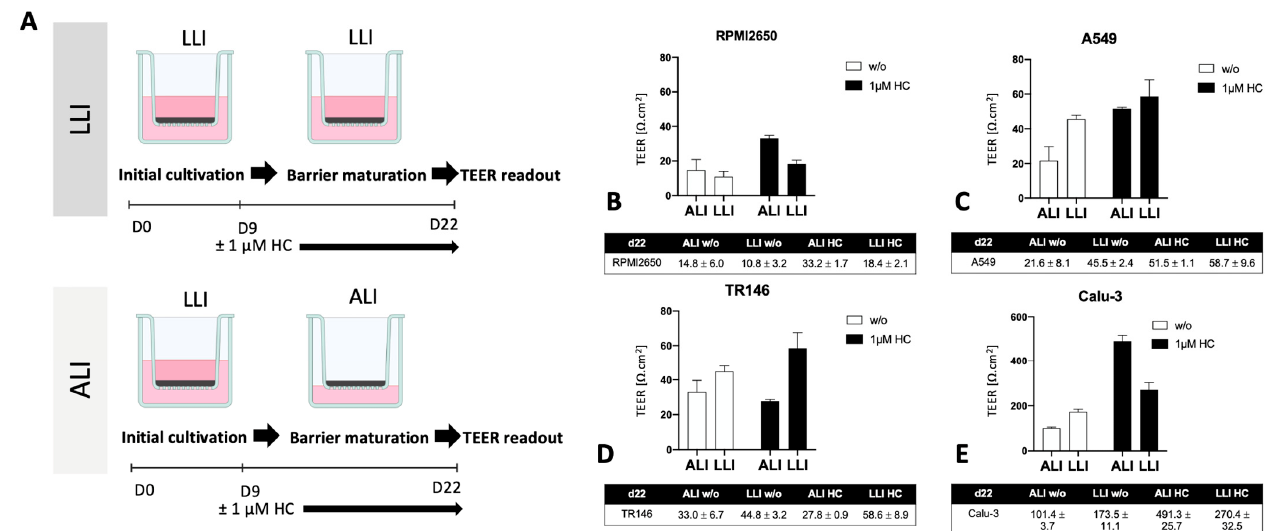
Figure 3. Impact of ALI compared to LLI cultivation on TEER in the presence and absence of hydrocortisone. ( A ) Visualized protocol for the LLI and ALI cultivation of mucosa cells grown on porous membrane inserts over a period of 22 days. ( A – C ) Comparative analysis of LLI with ALI cultivation (initial LLI cultivation period of 8 days followed by 14 days of barrier maturation at the ALI) in the presence and absence of hydrocortisone (HC) for ( B ) RPMI2650, ( C ) A549, ( D ) TR146, and ( E ) Calu- 3. Data are expressed as mean ± standard deviation for n = 3 replicates.